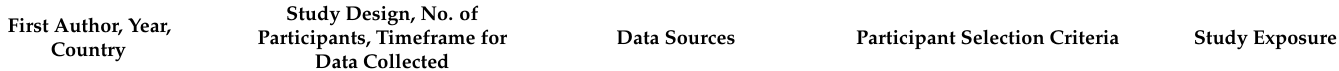
Table 1. Characteristics of the included studies examining pregnancy-related complications and incidence of atrial fibrillation.